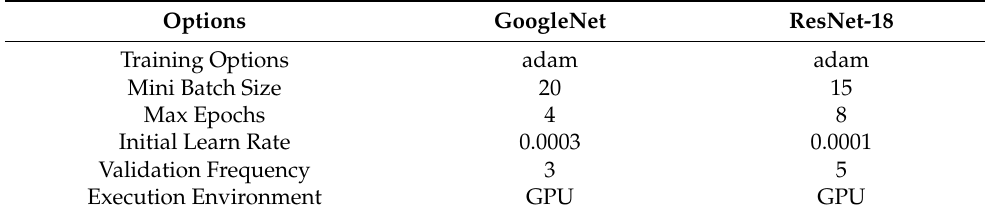
Table 6. Training parameter options for GoogleNet and ResNet-18